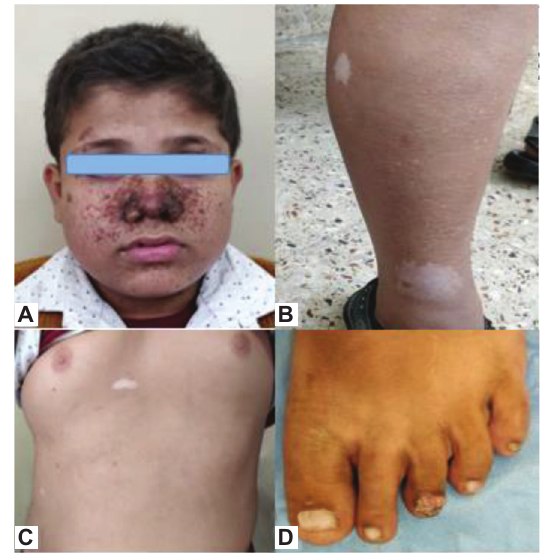
Figure 1: External clinical manifestations of tuberous sclerosis in the patient. (A) Facial angiofibromas in a classic butterfly pattern, adenoma sebaceum. Also seen is a typical forehead fibrous plaque, often seen as an early sign of tuberous sclerosis. (B) Multiple hypomelanic macules on the right lower limb, also known as ash leaf spots, caused due to lack of melanin. (C) Similar hypomelanic macule on the anterior chest wall.